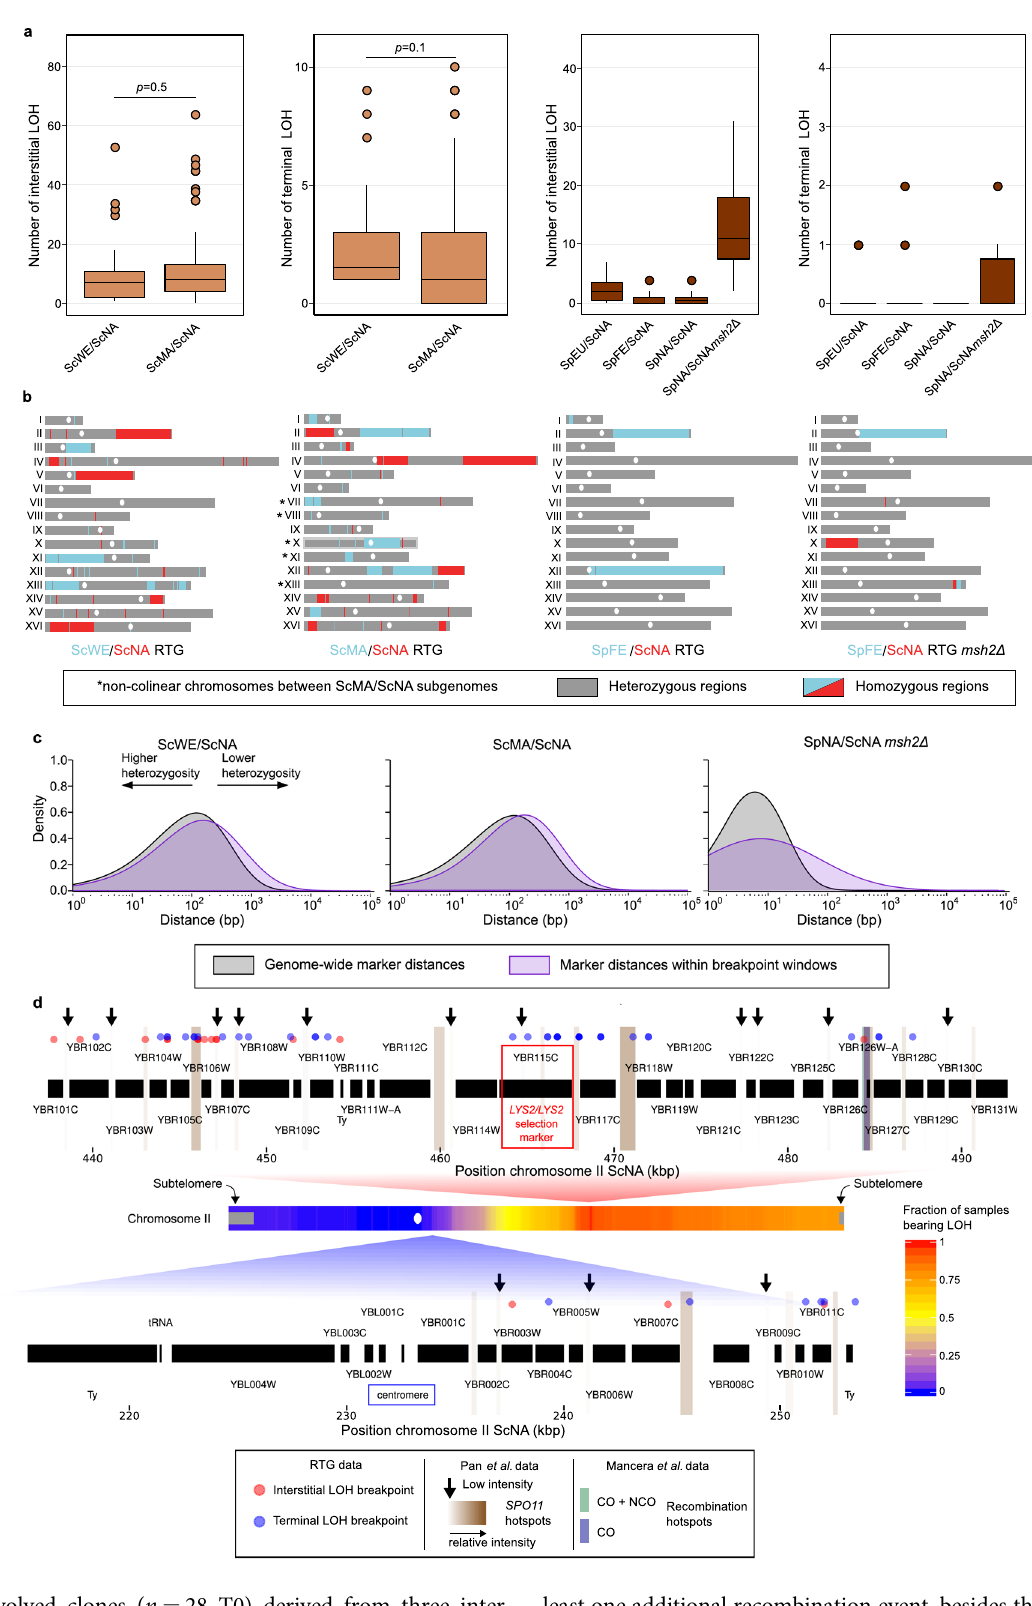
and non-evolved clones ( n = 28 T0) derived from three inter- species S. paradoxus/S. cerevisiae hybrids (Supplementary Data Set 9). Their genome-wide RTG recombination was less extensive compared to intraspecies hybrids, generating fewer and smaller LOH (Fig. 3a – b, Supplementary Fig. 2, Supplementary Data Set S6). Nevertheless, 22 out of 34 wild-type RTG isolates had at